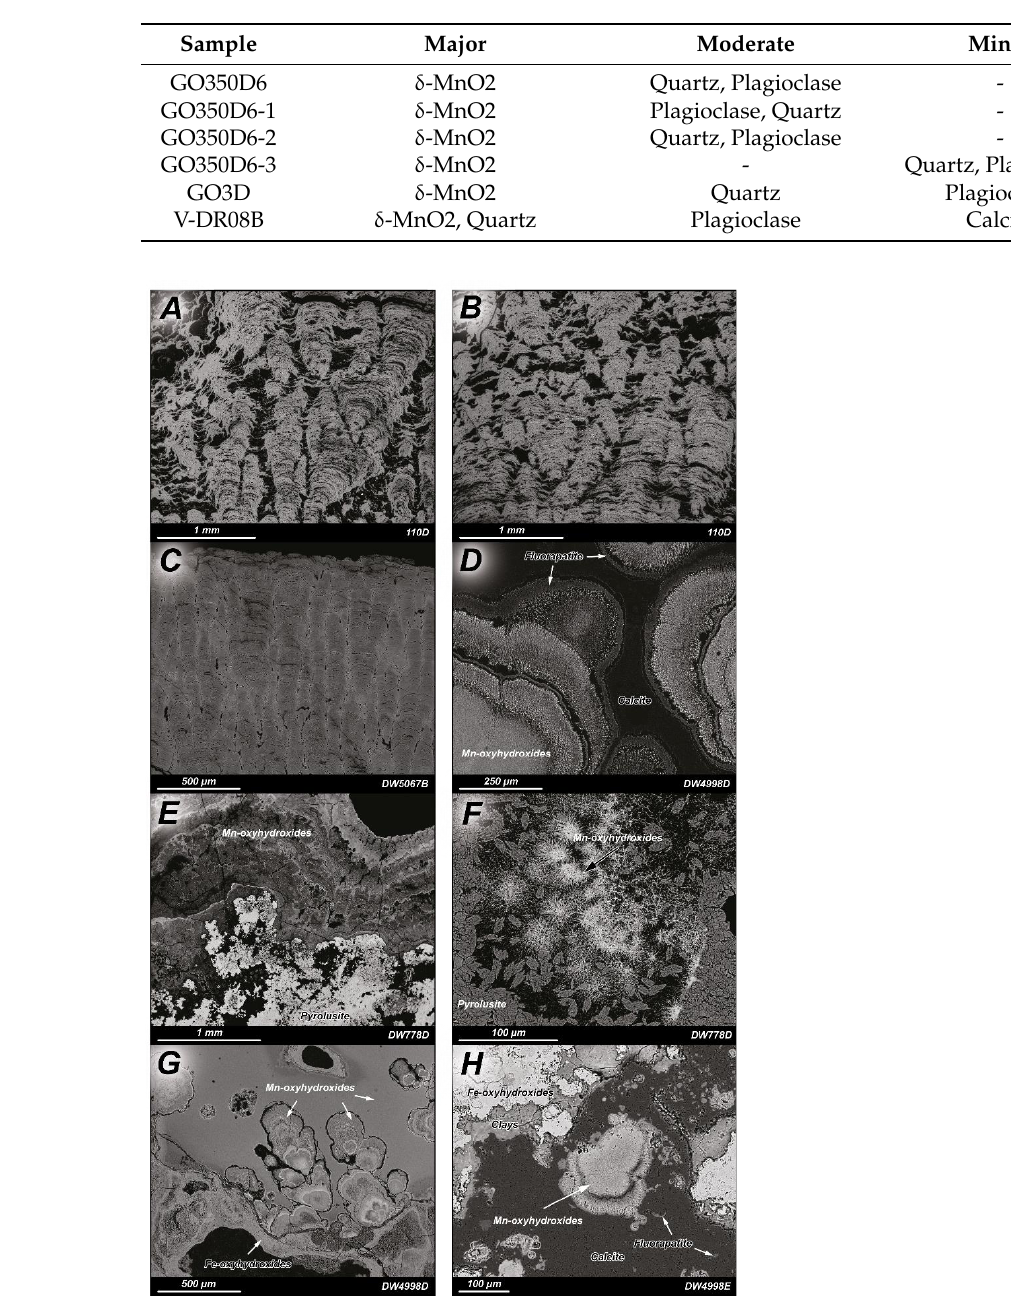
Figure 4. BSE images of selected Fe-Mn deposits samples. ( A – D ): Fe-Mn crusts; ( E – H ): Hydrother- mal Mn + Ca ± Fe deposits; ( A ) Large columnar structure with quartz infill; ( B ) Laminar structure (bottom) evolving upwards to columnar structure; ( C ) Massive columnar texture formed by dense pillar structure with little amount of carbonate infill; ( D ) Well-crystallised needle-like Mn-oxyhy- droxides with overgrowth or crosscut by Ca-phosphate (fluorapatite); ( E ) Well-crystallised needle- like Mn-oxyhydroxides infilling cavity and surrounded by pyrolusite; ( F ) Pyrolusite and ± calcite replacing areas composed of alternating layers of amorphous crystalline and microcrystalline Mn- oxyhydroxides; ( G ) Radially-oriented and spherulitic structure showing alternating layers of amor- phous crystalline, microcrystalline and crystalline Mn-oxyhydroxides cemented by a massive mi- crocrystalline Mn-oxyhydroxides ; ( H ) Microcrystalline and crystalline Mn-oxyhydroxides observed between hydrothermally altered hyaloclastite clasts replaced by clays and Fe-oxyhydroxides; a sub- sequent carbonate and Ca-phosphate (fluorapatite) infilling event is observed.